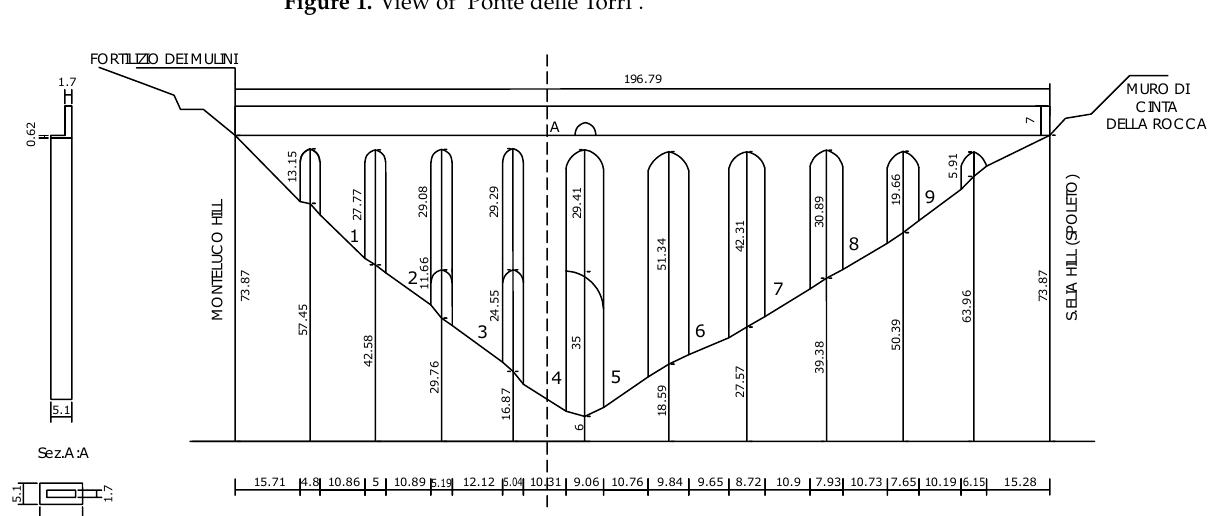
Figure 2. ‘Ponte delle Torri’, longitudinal section of the bridge from